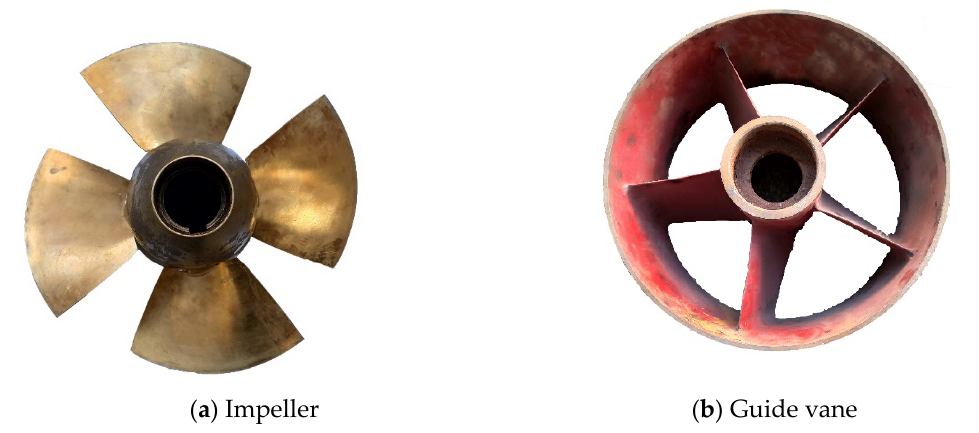
Figure 1. Hydraulic model of bidirectional axial flow pump.